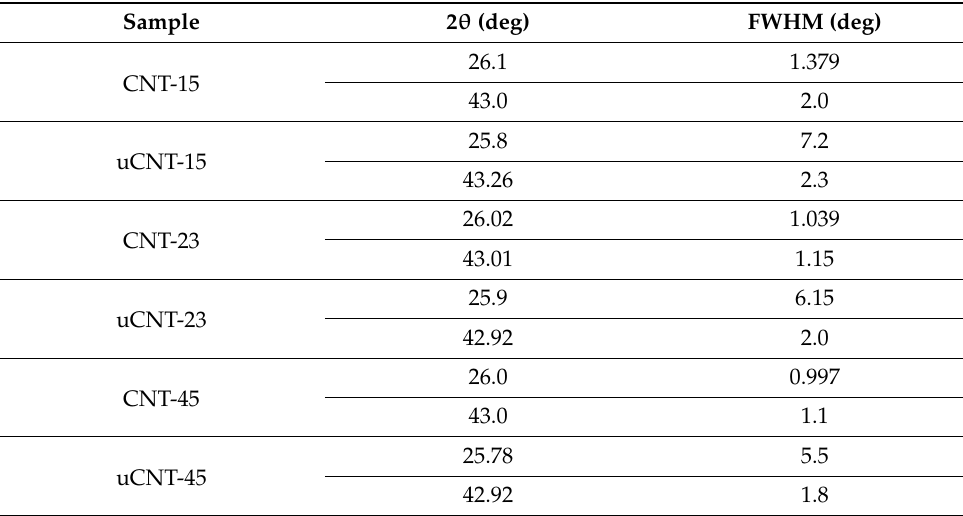
Table 2. Full width at half maximum of CNTs and uCNTs.